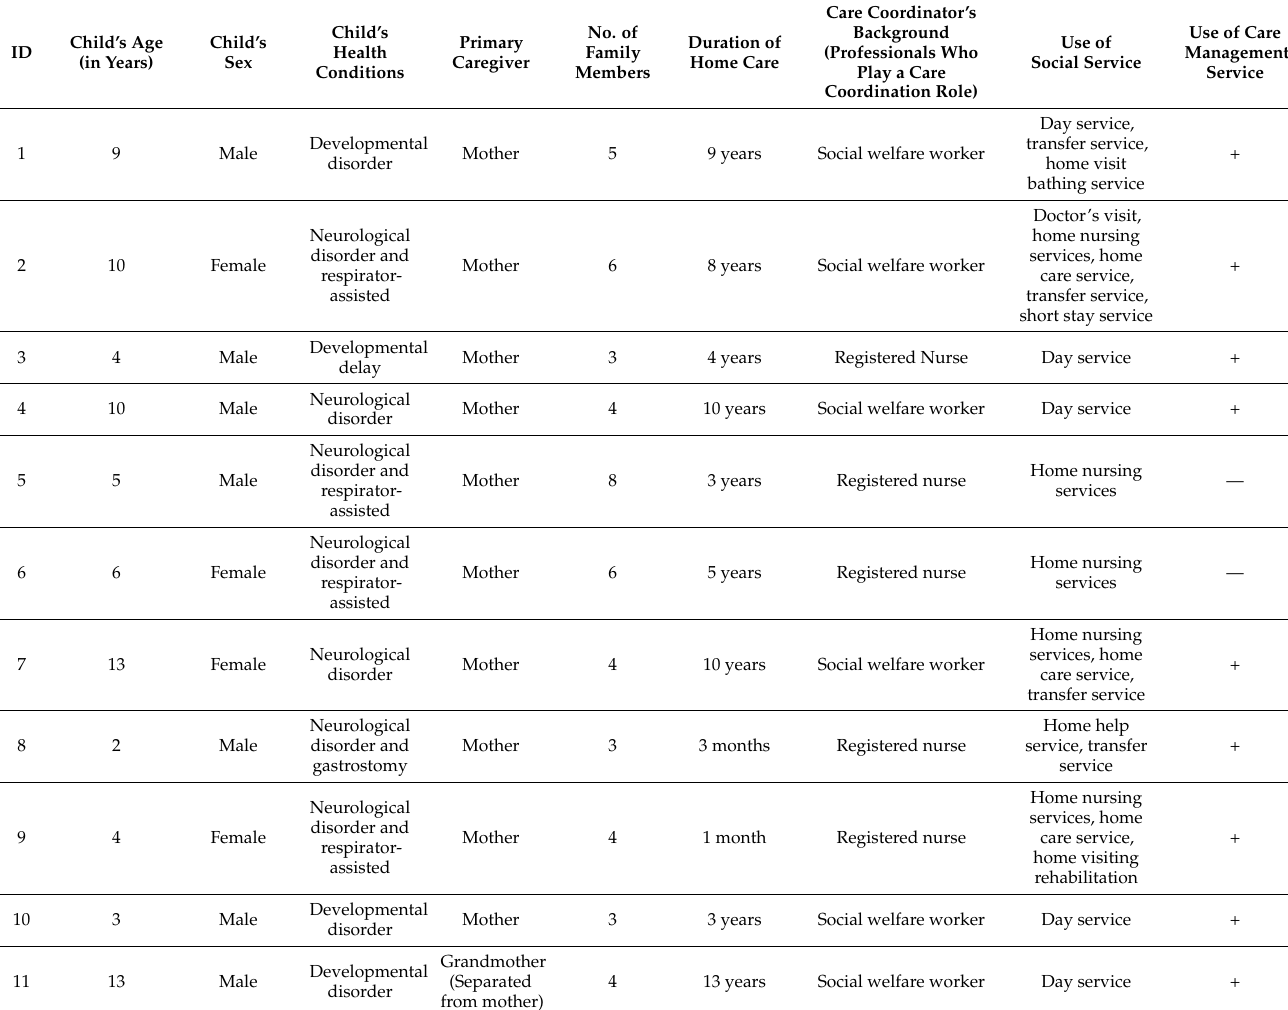
Table 1. Participants’